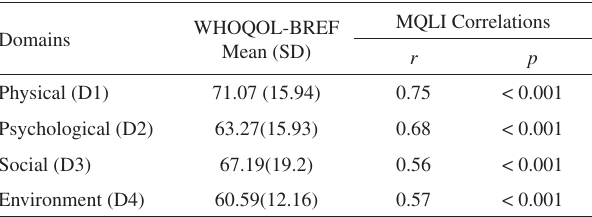
Table 1 - WHOQOL-BREF mean and standard deviation (SD) per domain and coefficients of correlation with the overall MQLI